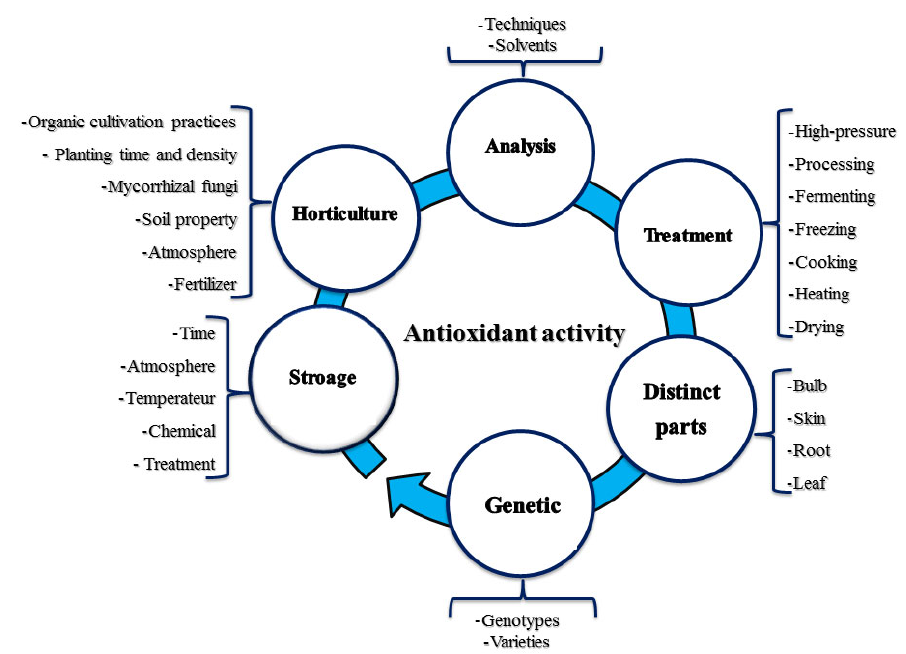
Figure 3. The most important factors a ff ecting the e ff ectiveness of